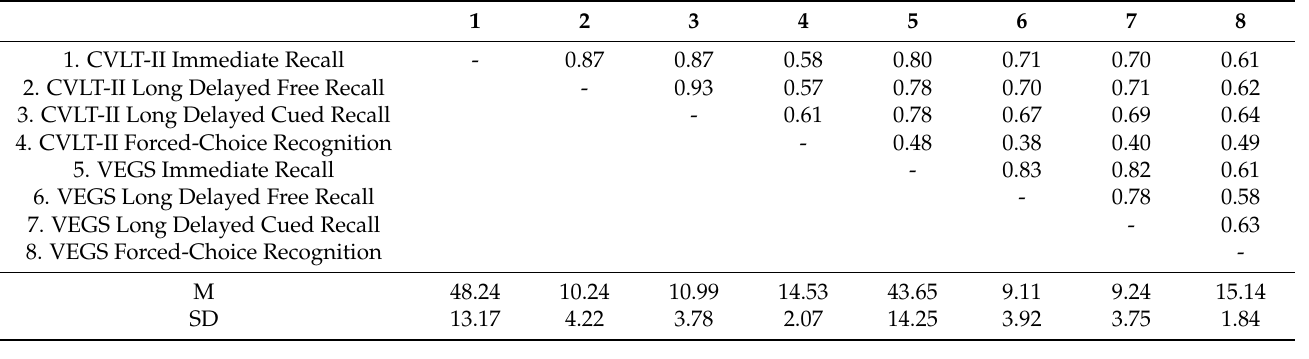
Table 2. Bivariate correlations between subtests with descriptive statistics for all variables of interest ( N = 156, all correlations significant at p <